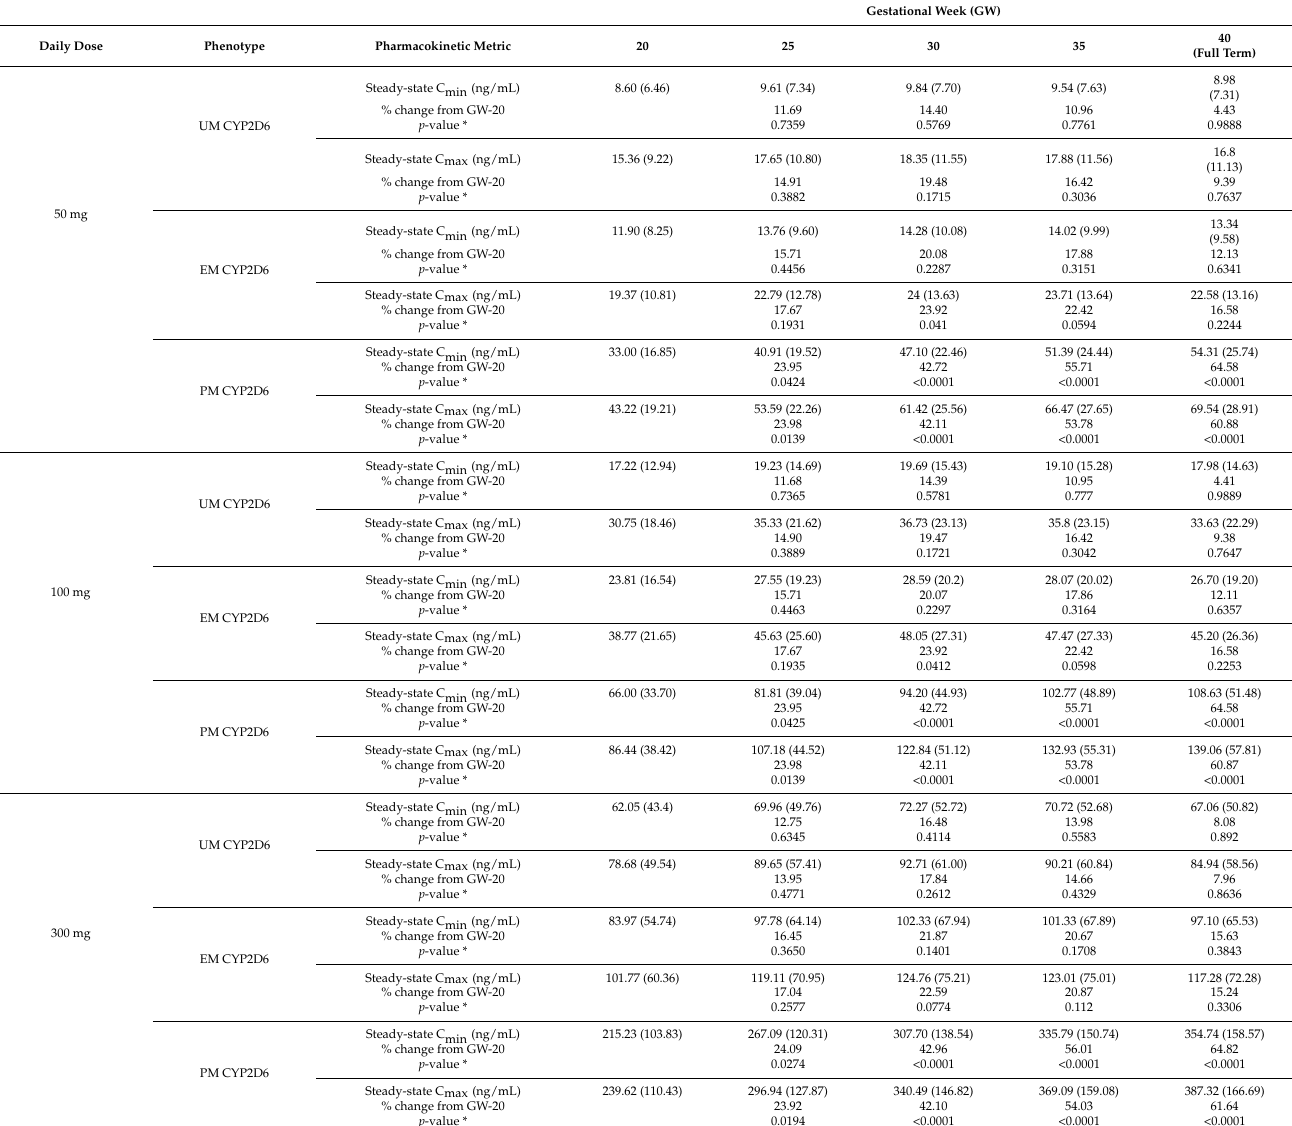
Table 6. Summary of simulated fluvoxamine umbilical cord concentrations during